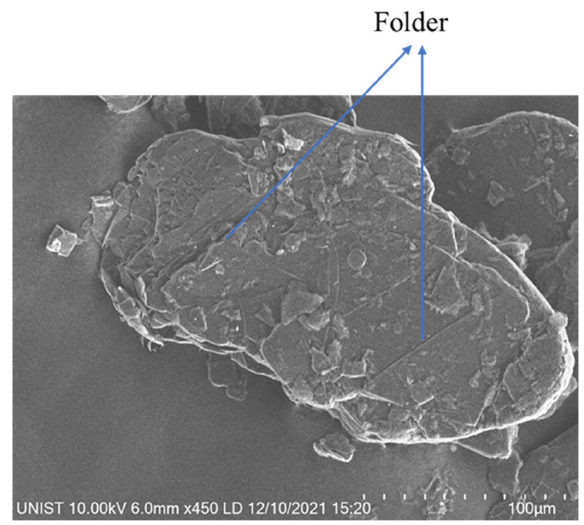
Figure 5. A SEM image of SGF.